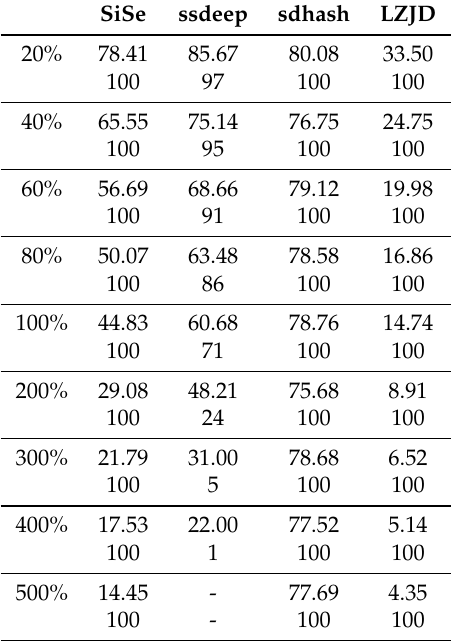
Table 29. Alignment robustness test with percentage blocks showing the score (first value) and the number of matches (second value) when testing 100 files taken from the t5